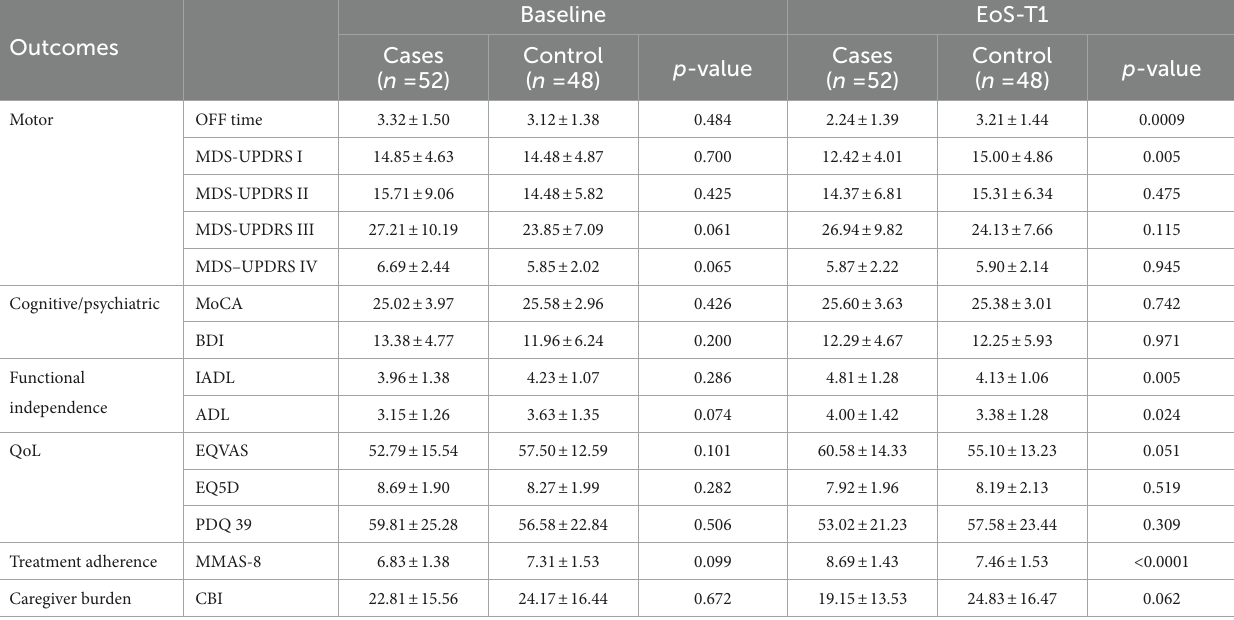
TABLE 2 Baseline and end of school (EoS) outcome measures for all participants and comparison between